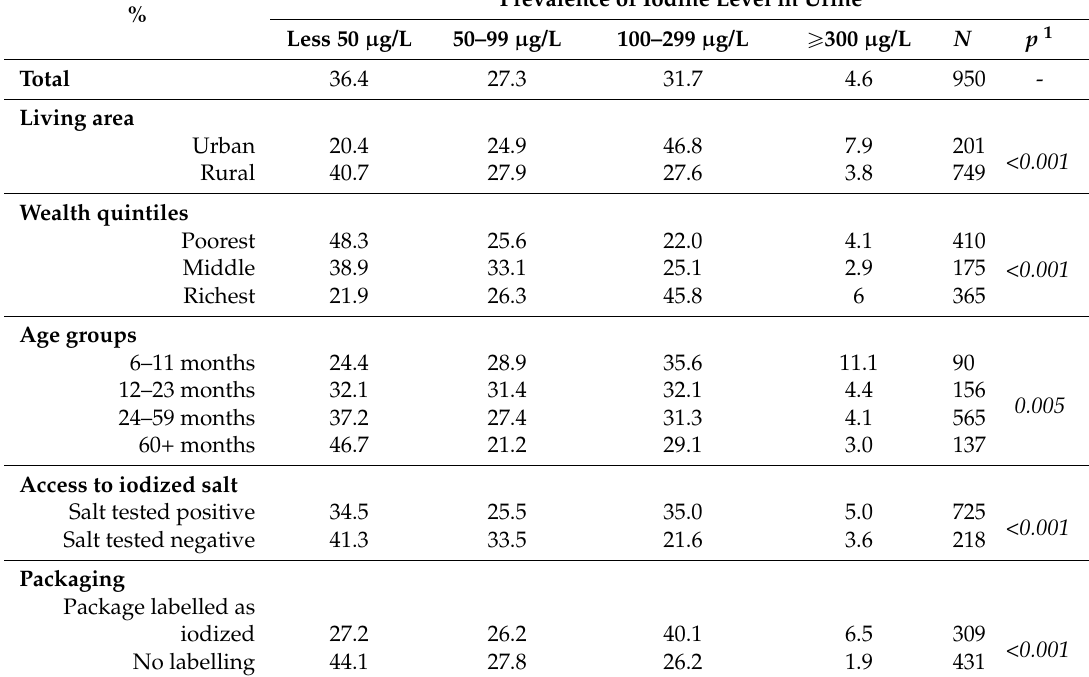
Table 4. Bivariate relationships between the prevalence of iodine level in urine and living area, wealth quintile, access to iodized salt, age groups, and access to equity card among children under 5 years of